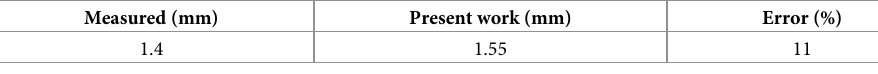
Table 3. Errors between the measured and present work.